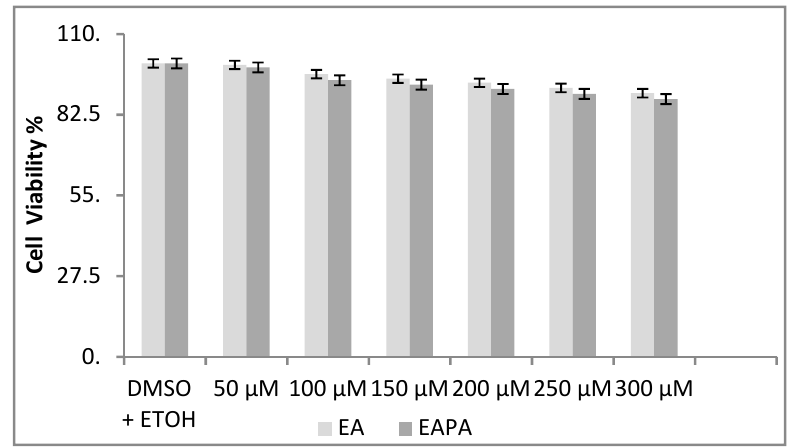
Figure 4. Influence of EA and EAPA on cell viability on A549 cells in a dose-dependent response by MTT assay. Cells were seeded into 96-well plates (1 × 10 4 cells/well) and allowed to adhere for overnight. Cells were treated with increasing concentrations of EA and EAPA (50–300 µM) separately for 24 h; ethanol was used as control. Data represent mean of ± S.D. from three independent experiments and were performed in triplicates. p < 0.05.